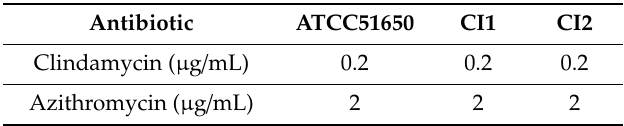
Table 1. S. aureus minimal inhibitory concentration for clindamycin and azithromycin ( µ g / mL) for ATCC51650, Clinical Isolate 1 (CI1) and 2